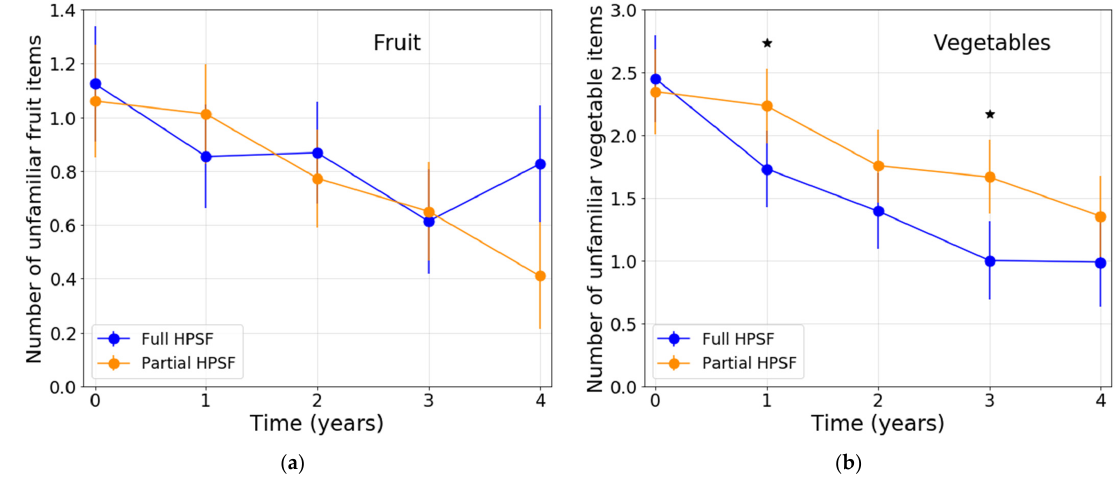
Figure 2. Estimated means of children’s fruit and vegetable familiarity at T0–T4: ( a ) Number of unfamiliar fruit items; ( b ) Number of unfamiliar vegetable items. Note. All analyses were adjusted for sex, study year at T0, SES, and ethnicity. Abbreviations: HPSF, Healthy Primary School of the Future. ★ Significant ( ≤ 0.05) difference between full and partial HPSF after correction for baseline.